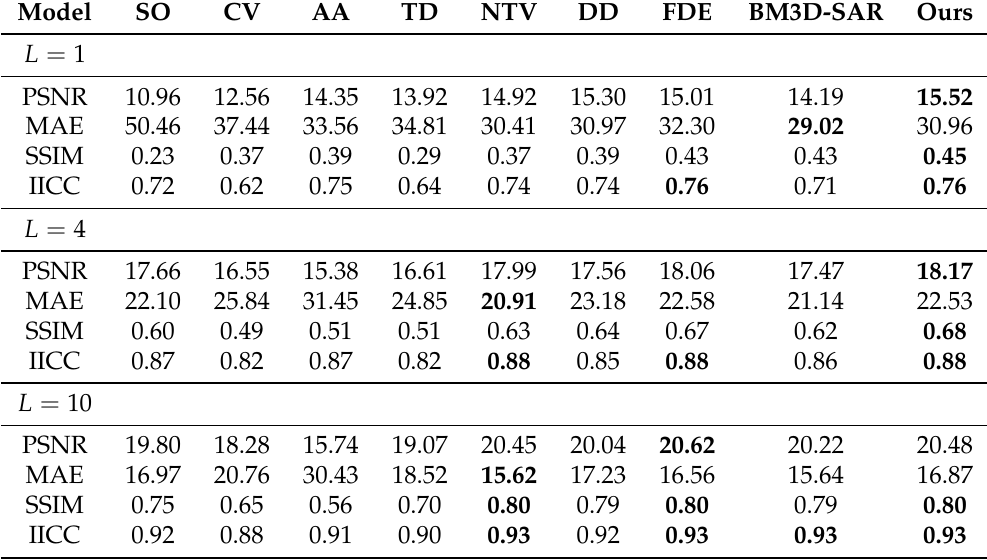
Table 4. Quantitative comparison of the different models for the texture2